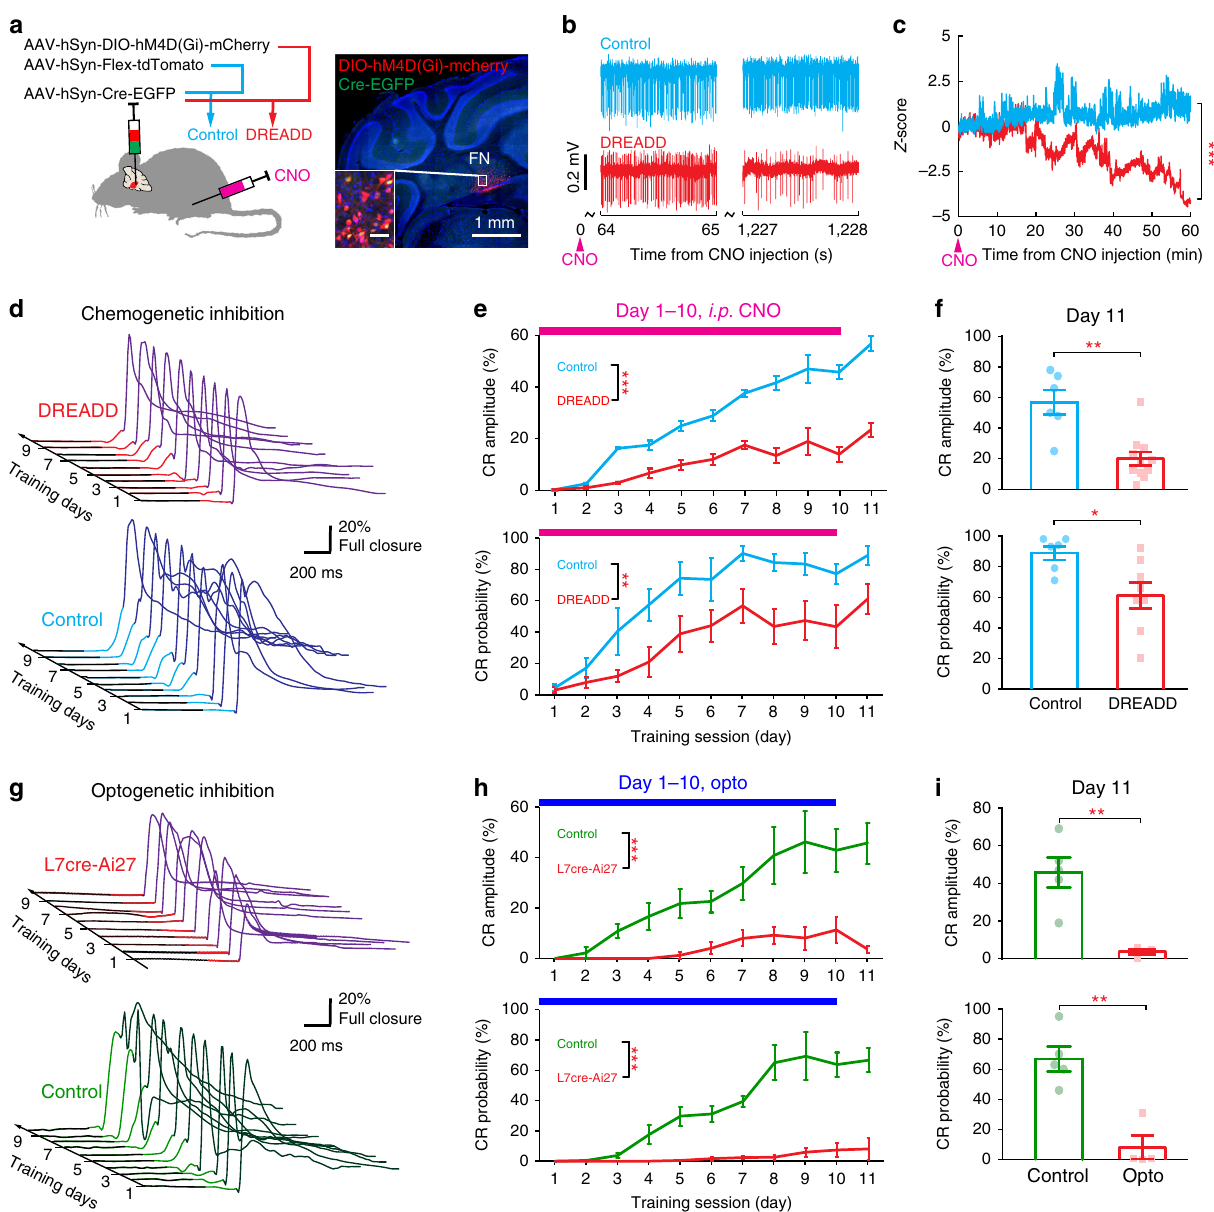
Fig. 6 Effects of Inhibiting the Ipsilateral FN on DEC Acquisition. a Experimental design for chemogenetic inhibition of the FN during DEC training (left). Inhibitory DREADD-hM4D (Gi) was expressed in FN ipsilateral to the trained eye (right, n = 6 mice) and tdTomato was expressed in control mice ( n = 8). Both control and DREADD mice received a i.p . CNO injection 15 – 20 min prior to training. Scale bar for the inserted image is 50 µ m. b Representative FN neuron responses from control and DREADD-expressing animals at early (left) and late (right) stages of recording, following the CNO injection. c Comparison of neuron activity over time after the CNO injection in control ( n = 37 neurons) and DREADD-expressing ( n = 19 neurons) mice (two-way repeated measures ANOVA, *** P < 0.001). d Progression of CR traces during DEC training in a representative DREADD mouse (CS – US interval shown in red) and a control mouse (CS – US interval shown in cyan). e Comparison of the CR acquisition during training (1 – 10 days), illustrated in the CR peak amplitude (upper) and CR-trial probability (lower), in control ( n = 8 mice, mean ± s.e.m.) and DREADD-expressing mice ( n = 6 mice, mean ± s.e.m., maximum likelihood estimation (two-sided), ** P < 0.01, *** P < 0.001). f Comparison of CR performance on the 11th day with the CNO injection omitted (mean ± s.e.m., two-sample t test (two-sided), * P < 0.05, ** P < 0.01). g – i Same as in ( d – f ), but for DEC training in mice with optogenetic perturbation. CR acquisition is suppressed in L7Cre-Ai27 mice ( n = 4 mice, mean ± s.e.m.) compared to the acquisition observed in the control group ( n = 5 mice, mean ± s.e.m., maximum likelihood estimation (two-sided), *** P < 0.001). Comparison of CR performance on the 11th day with opto-inhibition omitted (mean ± s.e.m., two-sample t test (two-sided), ** P < 0.01). See the exact P values for each comparison in the Source Data fi during DEC. We found well-timed modulations in a group of spikes and complex spikes in relation to both the CS and US. excitatory FN neurons in response to the CS and US, suf fi ciently allowing the prediction of the CR amplitude on a trial-by-trial basis. Consistent with the DEC-related modulation in the FN, its upstream vermal PCs showed modulations of both their simplex